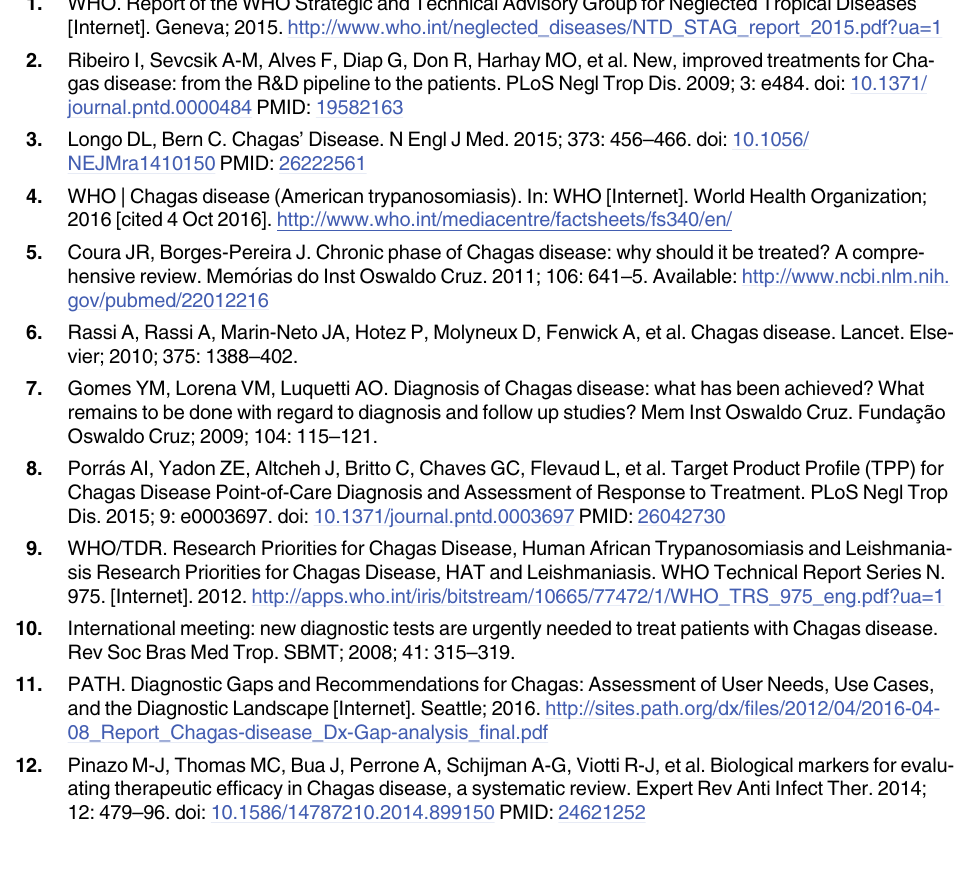
S1 Table. Individual ranking of the nine diagnostic needs for Chagas disease conducted by 62 experts. For each expert, 3 points, 2 points, and 1 point were given to the first, second, and third priorities, respectively. S2 Table. Ranking and scores for all diagnostic needs for Chagas